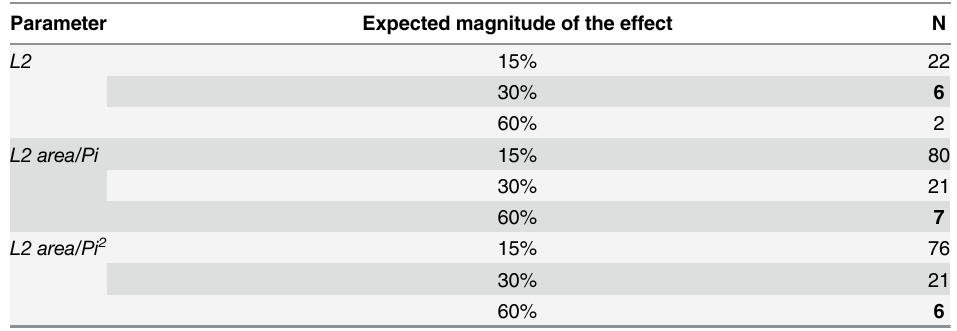
Table 5. Power analysis for in vivo EBUS.